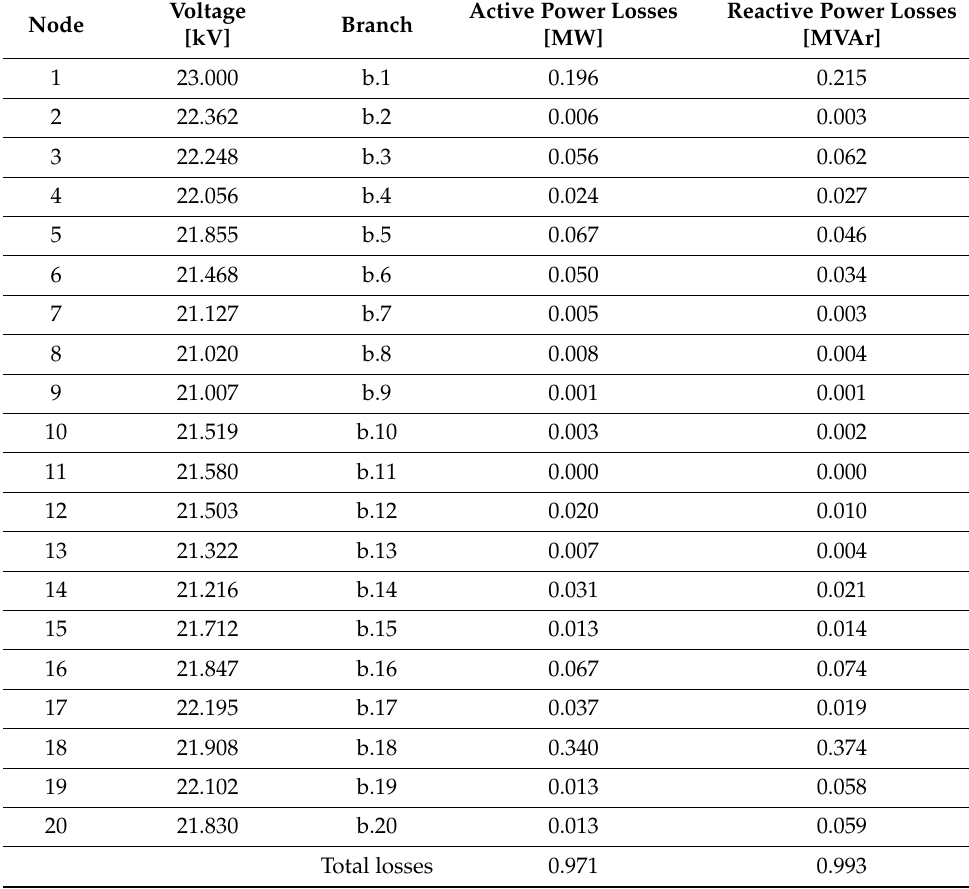
Table 4. Results of the steady-state